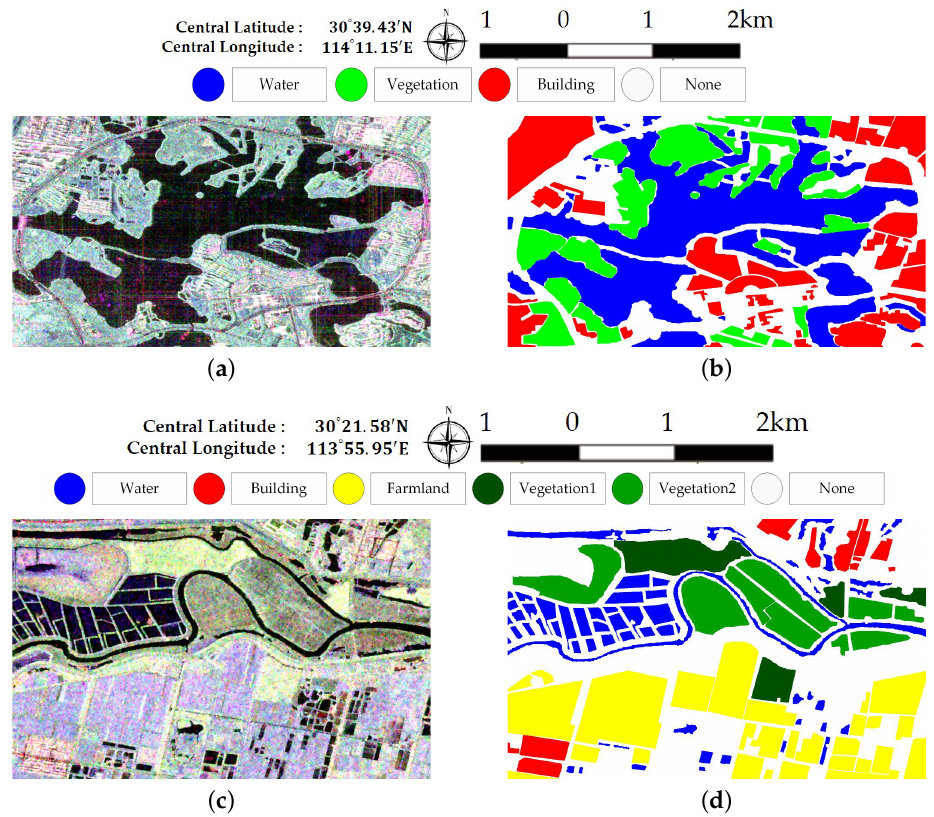
Figure 5. Sub-images of the Gaofen-3 PolSAR Data. ( a ) Pauli RGB image of dataset A. ( b ) The ground-truth map of ( a ). ( c ) Pauli RGB image of dataset B. ( d ) The ground-truth map of ( c